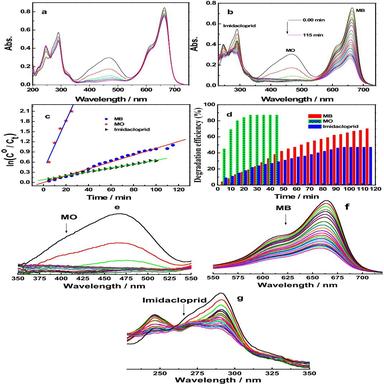
UV–Vis spectra of organic pollution (MO, MB, Imidacloprid) (1 × 10− 4 ) M with the absence of GO @TiO2ZnO.Ag HNM (a), with the presence of GO@TiO2ZnO.Ag HNM (5 mg/10 ml) (b). Linear plot of ln(C◦/Ct) with different times (c). The efficiency of degradation (%) of mixed organic pollution (d). (e, f, and g) degradation zoom of MB, MO, and Imidacloprid.